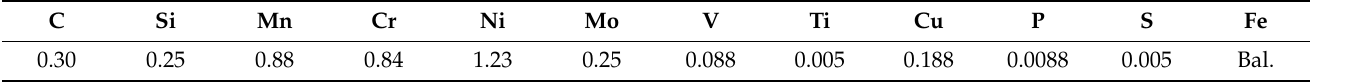
Table 1. Chemical composition of the experimental steel